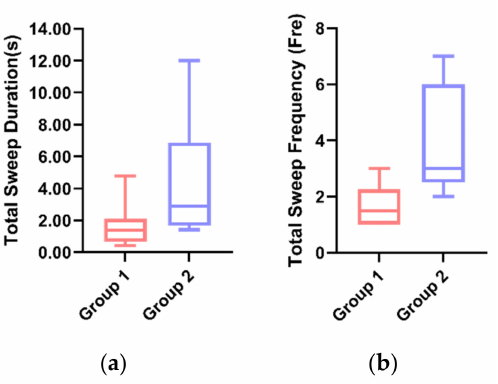
Figure 9. ( a ) Individual differences in the total sweep duration between the two groups. ( b ) Individ- ual differences in the total sweep frequency between the two groups.